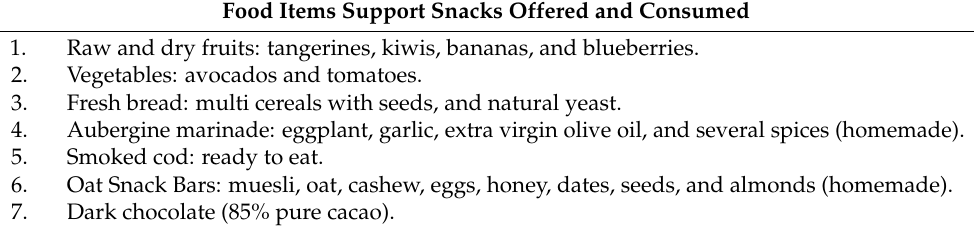
Table 1. Types of solid food items offered during the event